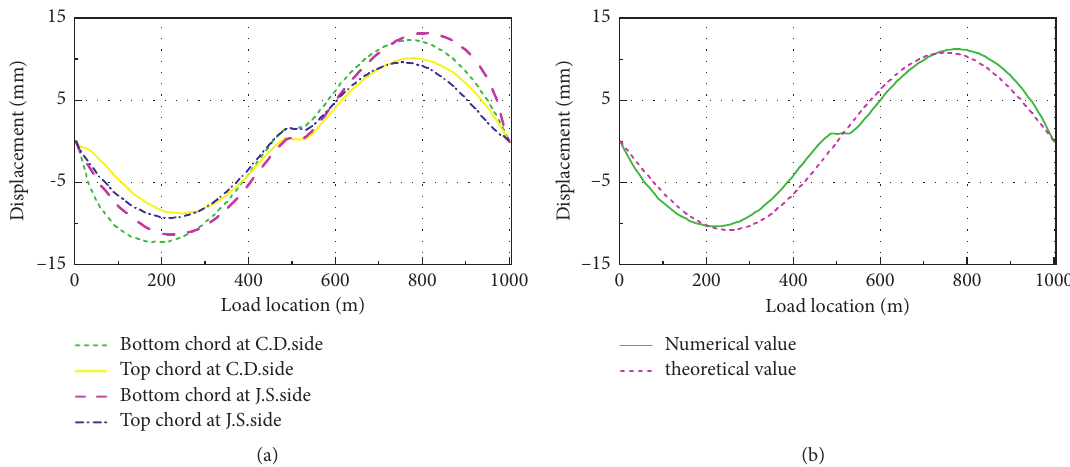
Figure 13: Longitudinal displacement at the end of the girder induced by a load at a slow speed moving on the bridge: (a) longitudinal displacement at different positions of girder ends; (b) average longitudinal displacement and equivalent longitudinal displacement at the ends.